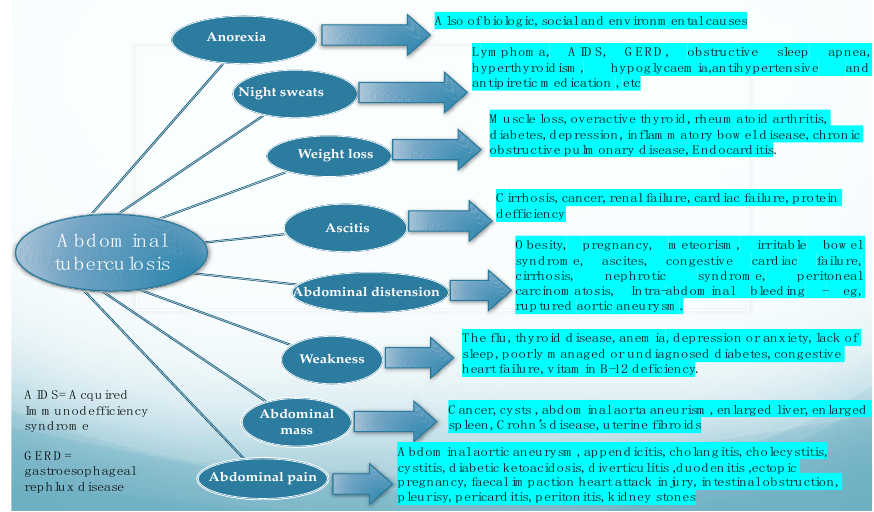
Figure 3. Main clinical manifestations of abdominal tuberculosis, and the main differential for each of them.